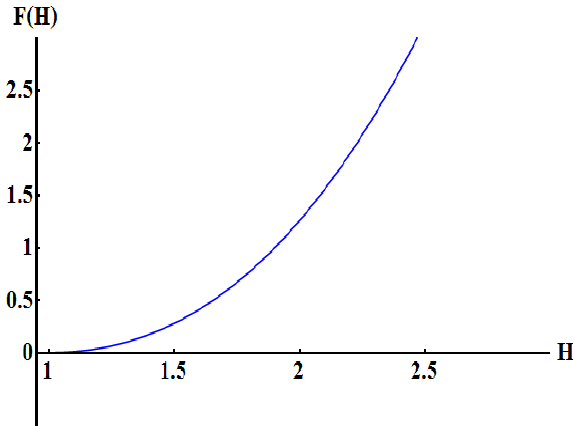
Figure 4. Characteristic function F ( H ) from Equation (47) for H ≥